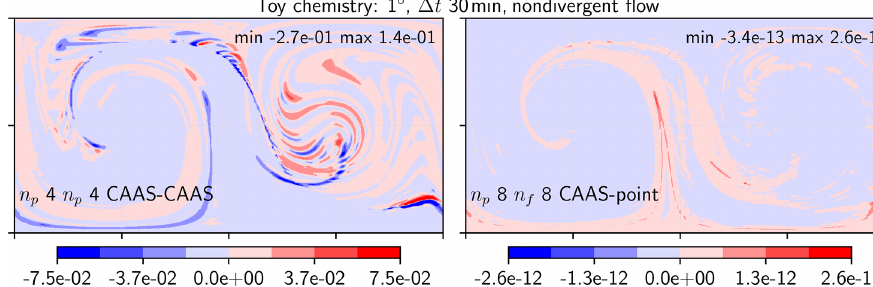
Figure 18. Same as Fig. 17 but, now, the images are of (X T − ¯ X T )/ ¯ X T